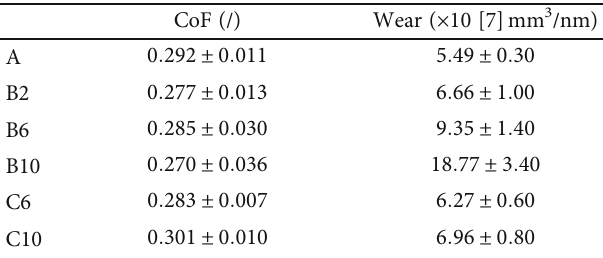
T Table 3: Coe ffi cient of friction (CoF) and wear of PA6/GF and m , c ), composites with EG5 and EG1000.